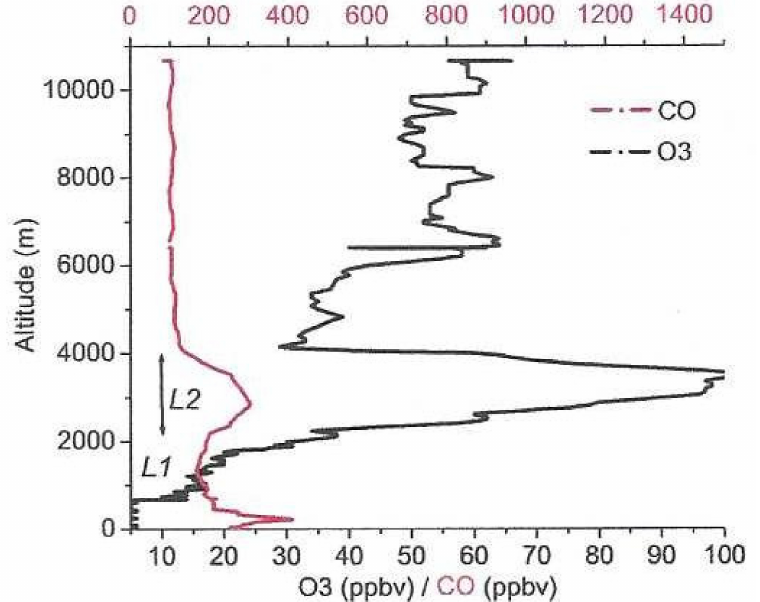
Figure 7. Example of vertical profile for O 3 and CO concentrations for 3 July 2003, showing a layer of O 3 and CO aloft above 2 km from measurements from an aircraft descending to Lagos airport at approximately 1100 h. Ll and L2 designate layers for the authors’ modeling study. Note that the instrument for O 3 concentration apparently stopped functioning at ~800 m of altitude. Figure from Global Commons, European Geoscience Union